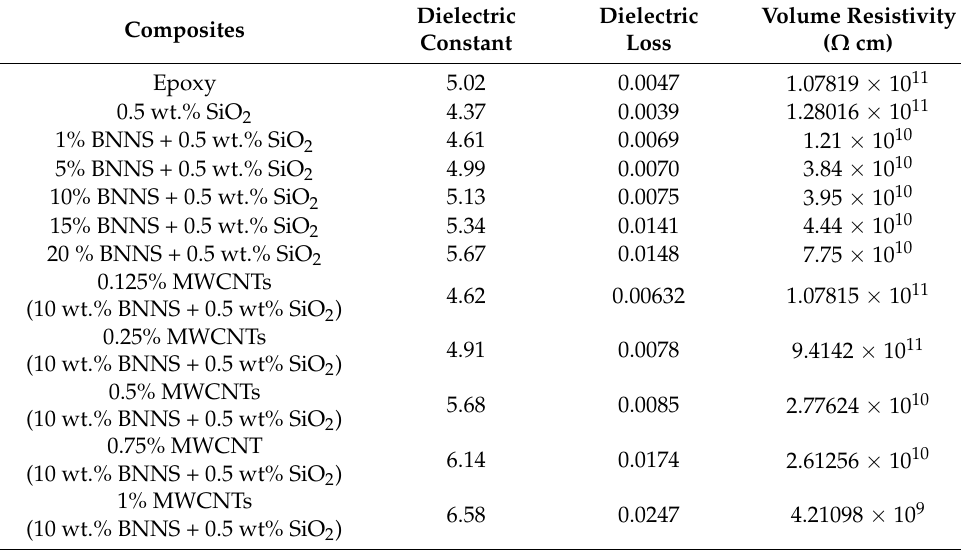
Table 1. Volume resistivity and dielectric properties of composites at 1000 Hz. Composites